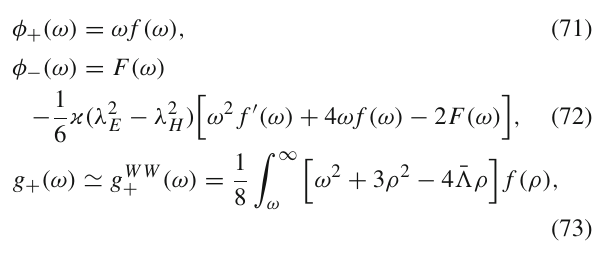
Fig. 4 under the f 0 + f (cid:4)